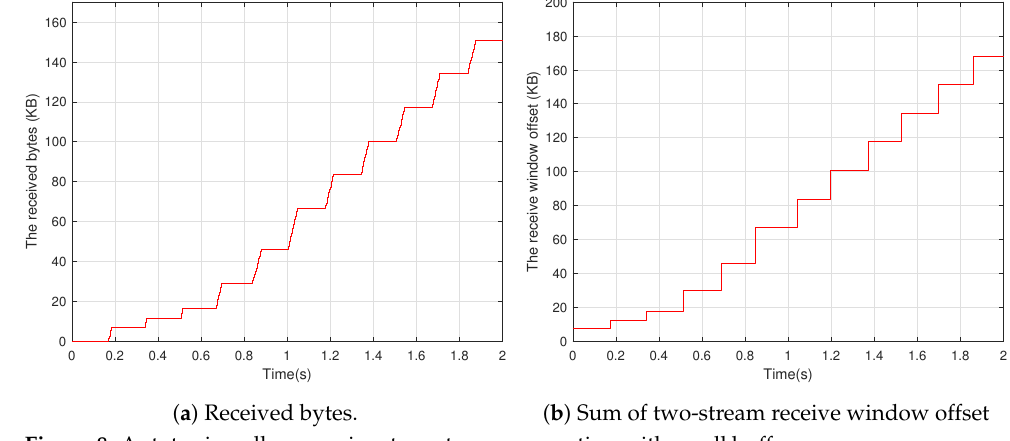
( b ) Sum of two-stream receive window offset Figure 8. Autotuning allowance in a two-stream connection with small buffer.